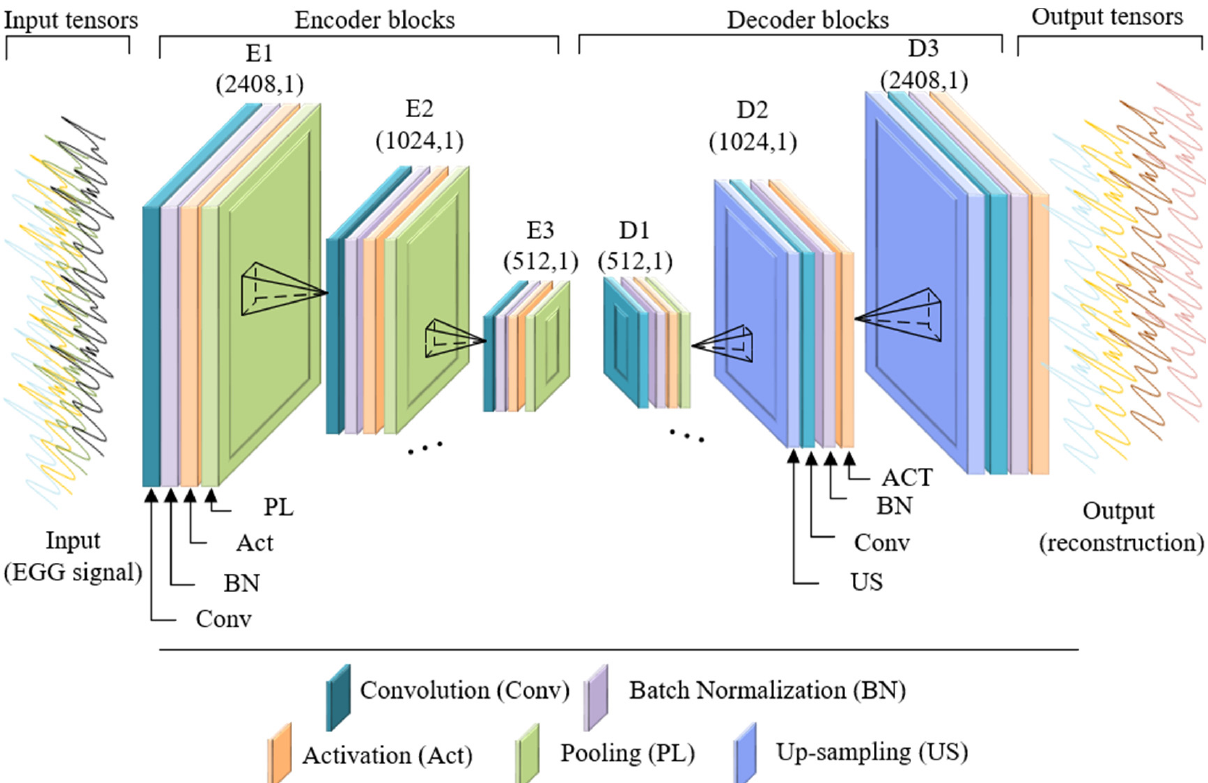
Figure 3. Architecture of the proposed deep AE.